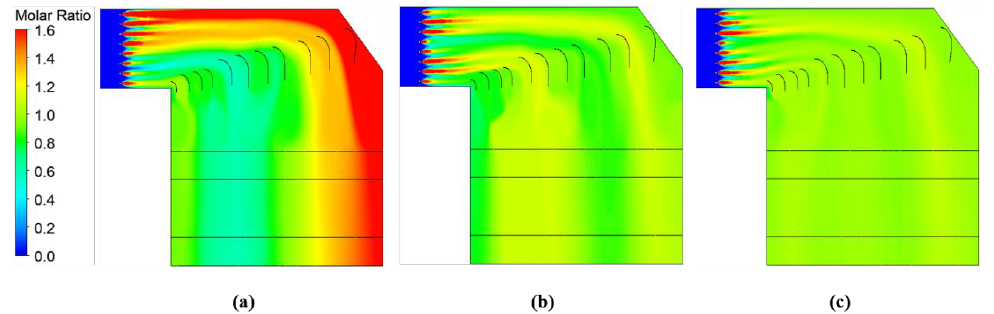
Figure 21. Distribution of NH 3 /NO around the flow passage for the random profile. ( a ) Constant injection; ( b ) adjusted injection; ( c ) optimized injection.